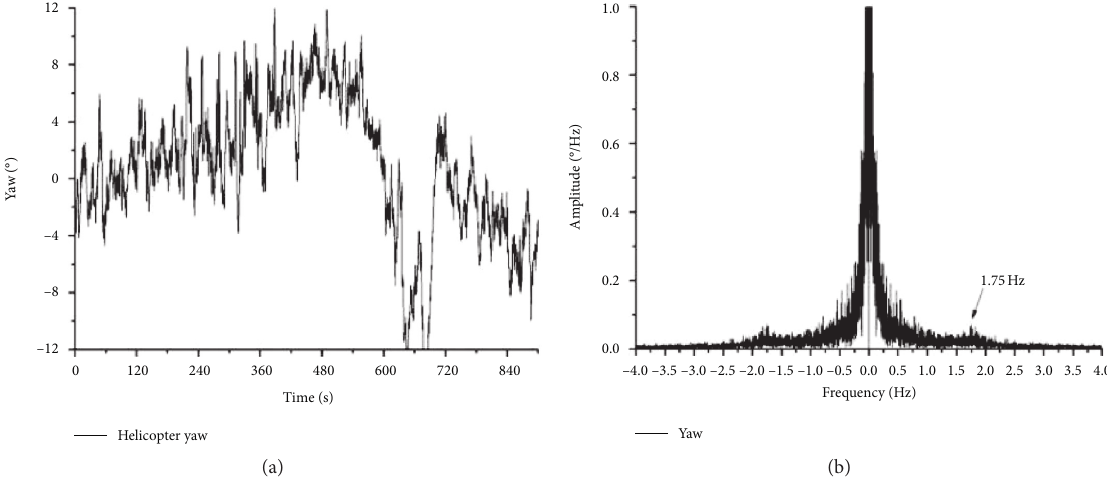
Figure 15: (a) Azimuth change of helicopter hovering. (b) Azimuth spectrum change of helicopter hovering.